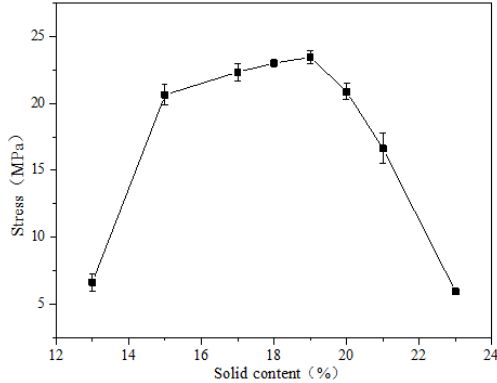
Figure 8. Temperature resistance of p–DN hydrogel. Table 1. Temperature resistance of p–DN